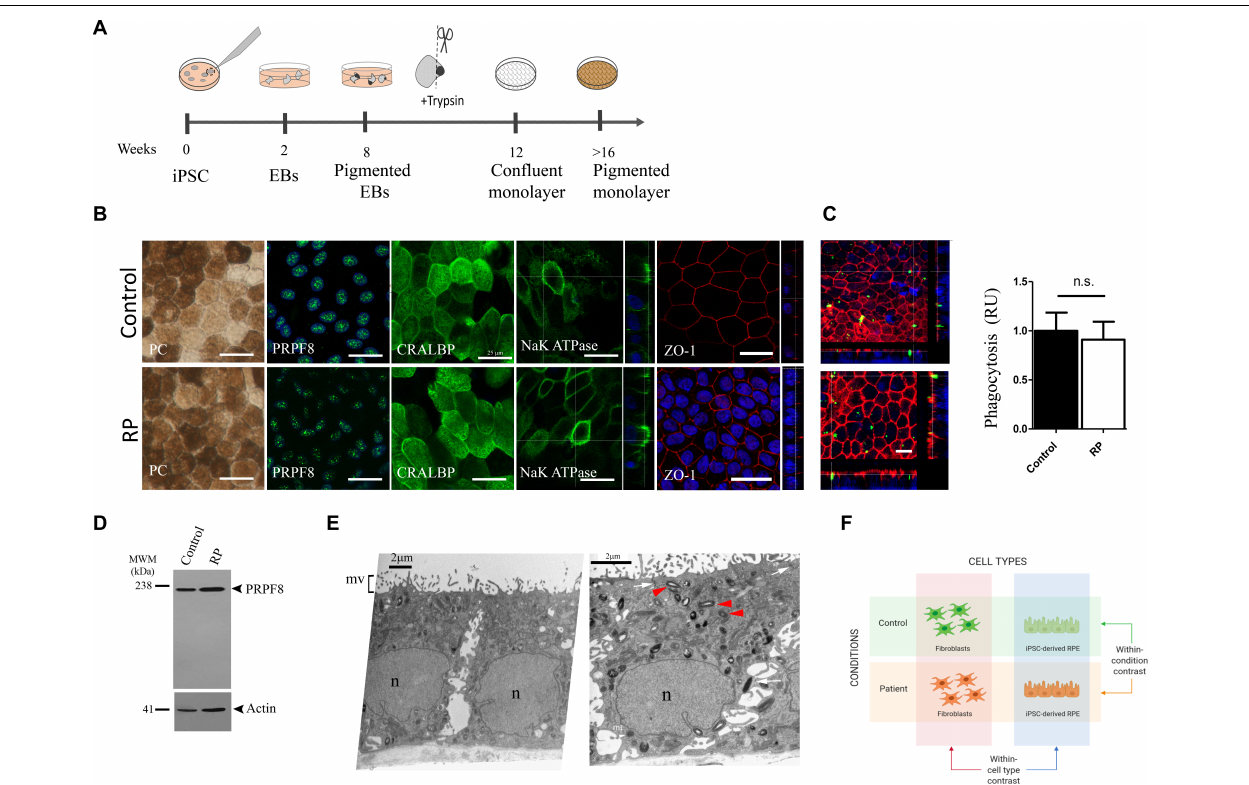
FIGURE 1 | Generation of iPSC-RPE cells from patient and control. (A) Schematic of iPSC differentiation toward RPE. (B) Characterization of iPSC-RPE. Bright-field images of iPSC-RPE monolayers. Immunocytochemistry to PRPF8 and characteristic RPE markers CRALBP, Na + /K + -ATPase (Na/K), and ZO-1. Vertical simulation sections for Na + / K + ATPase show mainly apical distribution and ZO-1 showing typical apical lateral junction distribution. (C) POS phagocytosis assay: FITC-labeled POS (green); F-actin is stained by phalloidin (red) to visualize cell morphology and internalization of POS and quantitative analyses of ingested POS. (D) Western blot analysis of PRPF8. (E) Transmission electron microscopy of patient iPSC-RPE. Left panel: cuboid polarized RPE cell organized in monolayer with basally located nucleus (n) and apically distributed microvilli (mv). Right panel: RPE cells show melanin granules (red arrowheads) apically from the nucleus, intercellular junctional complexes that include the tight junctions, adherens junctions (arrows), and membrane interdigitations (arrowheads), and basally positioned nucleus (n). (F) Contrasts analyzed by RNA-Seq. Created with BioRender (https://biorender.com/). Data are expressed as means ± SD, n = 3 assays from two differentiation experiments; Student’s t test, n.s., non-significant. Scale bar 25 µ m where not